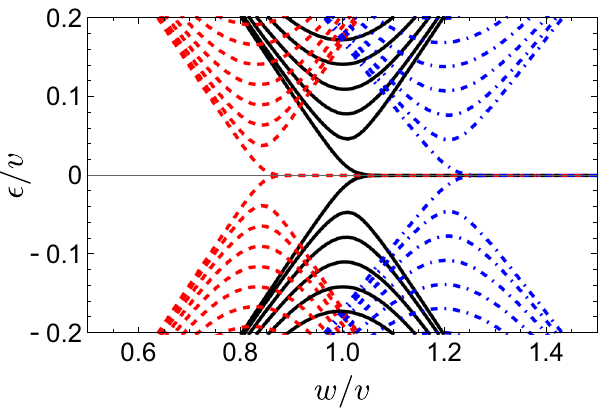
Fig. 2 Energy spectrum of the Su-Schrieffer-Heeger chain in presence of cavity. Energy spectrum of the Su-Schrieffer-Heeger model coupled to a single mode cavity as a function of hopping ratio w / v . Black solid lines correspond to zero light-matter coupling g = 0 and red dashed (blue dot- dashed) lines correspond to the sublattice distance b 0 = 0.8 ( b 0 = 0.2) and g = 20. Other parameters are chosen as intracell hopping v = 1, number of unit cells L = 100, lattice constant a 0 = 1, cavity frequency ω c = 0.5, and maximum number of photons N max =